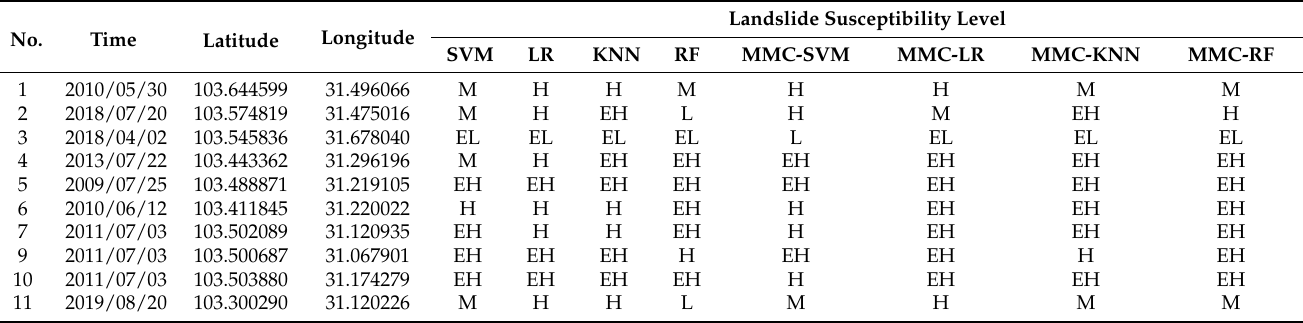
Table 5. LSM validation using new landslide